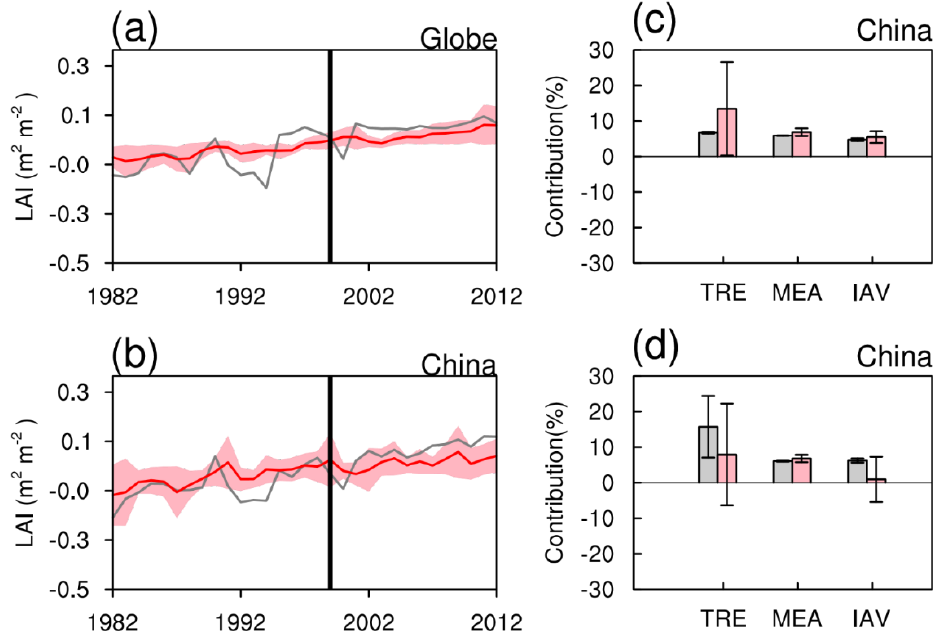
Figure 1. ( a , b ) Interannual anomalies of LAI in the growing season (April – September) during the period of 1982 – 2012 from satellite-based datasets (gray line) (GIMM LAI and GLASS LAI) and the mean of TRENDY models (red line). Shaded pink areas designate ± 1 standard deviation ( σ ). The left of the thick black vertical line represents the warming period from 1982 to 1998, while the right represents the warming hiatus period from 1999 to 2012 for the whole terrestrial ecosystem and China, respectively. ( c , d ) Contribution of China to the global mean, trend, and interannual variability of LAI during ( c ) the period of 1982–1998 and ( d ) 1999–2012. Horizontal lines indicate ± σ . Gray bars mean the average of satellite-based datasets; pink bars represent TRENDY ensemble (TRE: the trend of LAI; MEA: the mean of LAI; IAV: inter-annual variability of